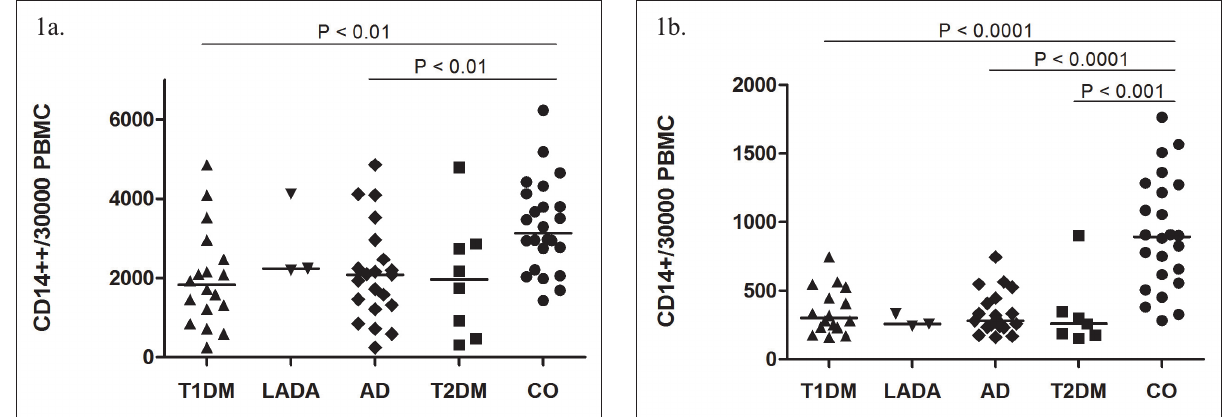
Fig. 1. CD14 ++ (a) and CD14 + (b) monocyte counts in diabetic patients and healthy controls. Absolute counts of CD14 ++ (a) and CD14 + cells (b) were obtained from 30000 events representing the whole PBMC population. The horizontal bars correspond to group medians. T1DM, type 1 diabetes mellitus (N = 18); LADA, latent autoimmune diabetes in adults (N = 3); AD, pooled autoimmune diabetes (N = 21); T2DM, type 2 diabetes mellitus (N = 8); CO, healthy control group (N = 24); PBMC, peripheral blood mononuclear